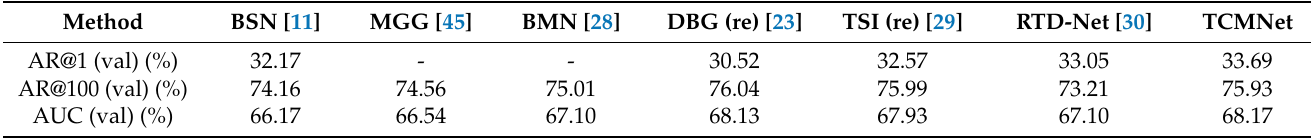
Table 1. Comparison between TCMNet and other state-of-the-art temporal action proposal generation methods on the validation set of ActivityNet-1.3 in terms of AR@AN and AUC. “re” denotes re- implementation by